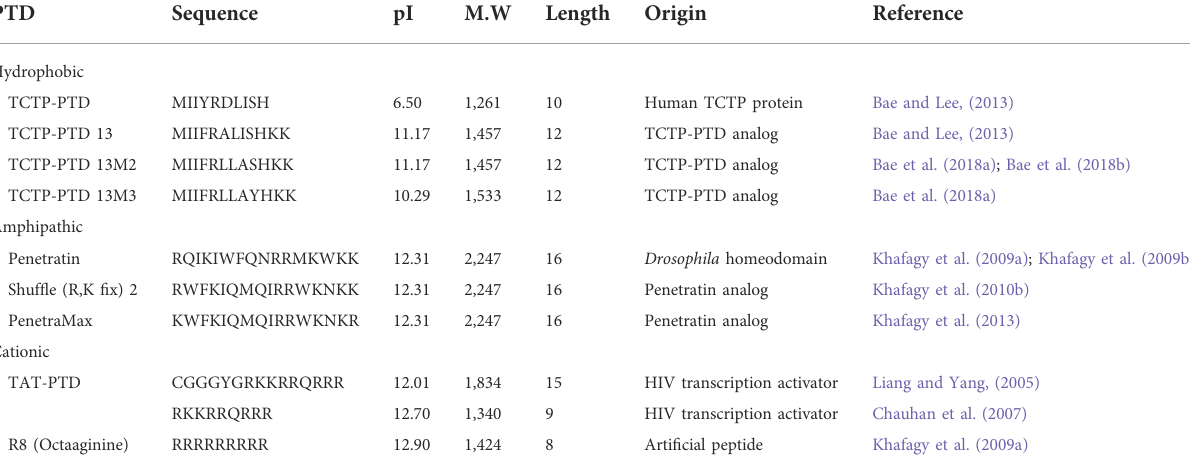
TABLE 1 Examples of CPPs described in the present article. The theoretical isoelectric point and molecular weight were obtained using the ExPasy website (https://web.expasy.org/compute_pi/). PTD